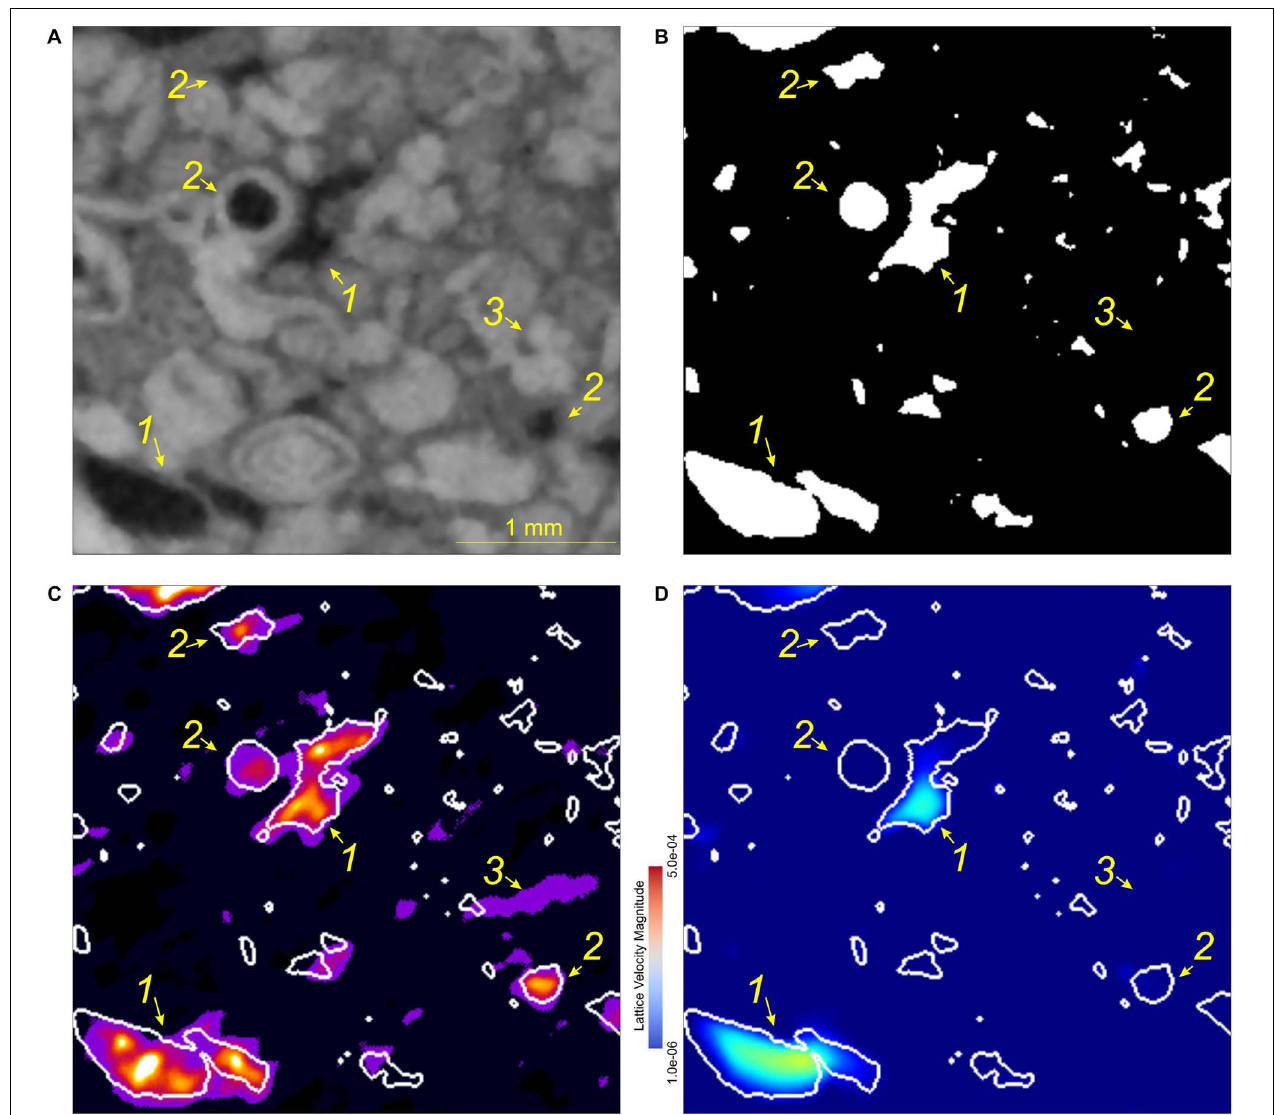
FIGURE 8 | Detail of the comparison of resulting images ( Figure 7 ). (A) XCT at dry conditions, (B) segmented pores from XCT, (C) Difference of NCT wet-dry images using as mask the segmented macropores from the XCT data, warmer colors indicate a higher saturation of water, (D) Lattice velocity images obtained by using LBM fluid flow simulation, warmer colors indicate a higher lattice velocity of the simulated flow. Three different cases are observed: (1) Macropores filled by water and connected according to LB simulation, (2) Macropores filled by water and poorly connected according to LB simulation, and (3) XCT sub-resolvable pores/throats filled by water only observed in Neutron